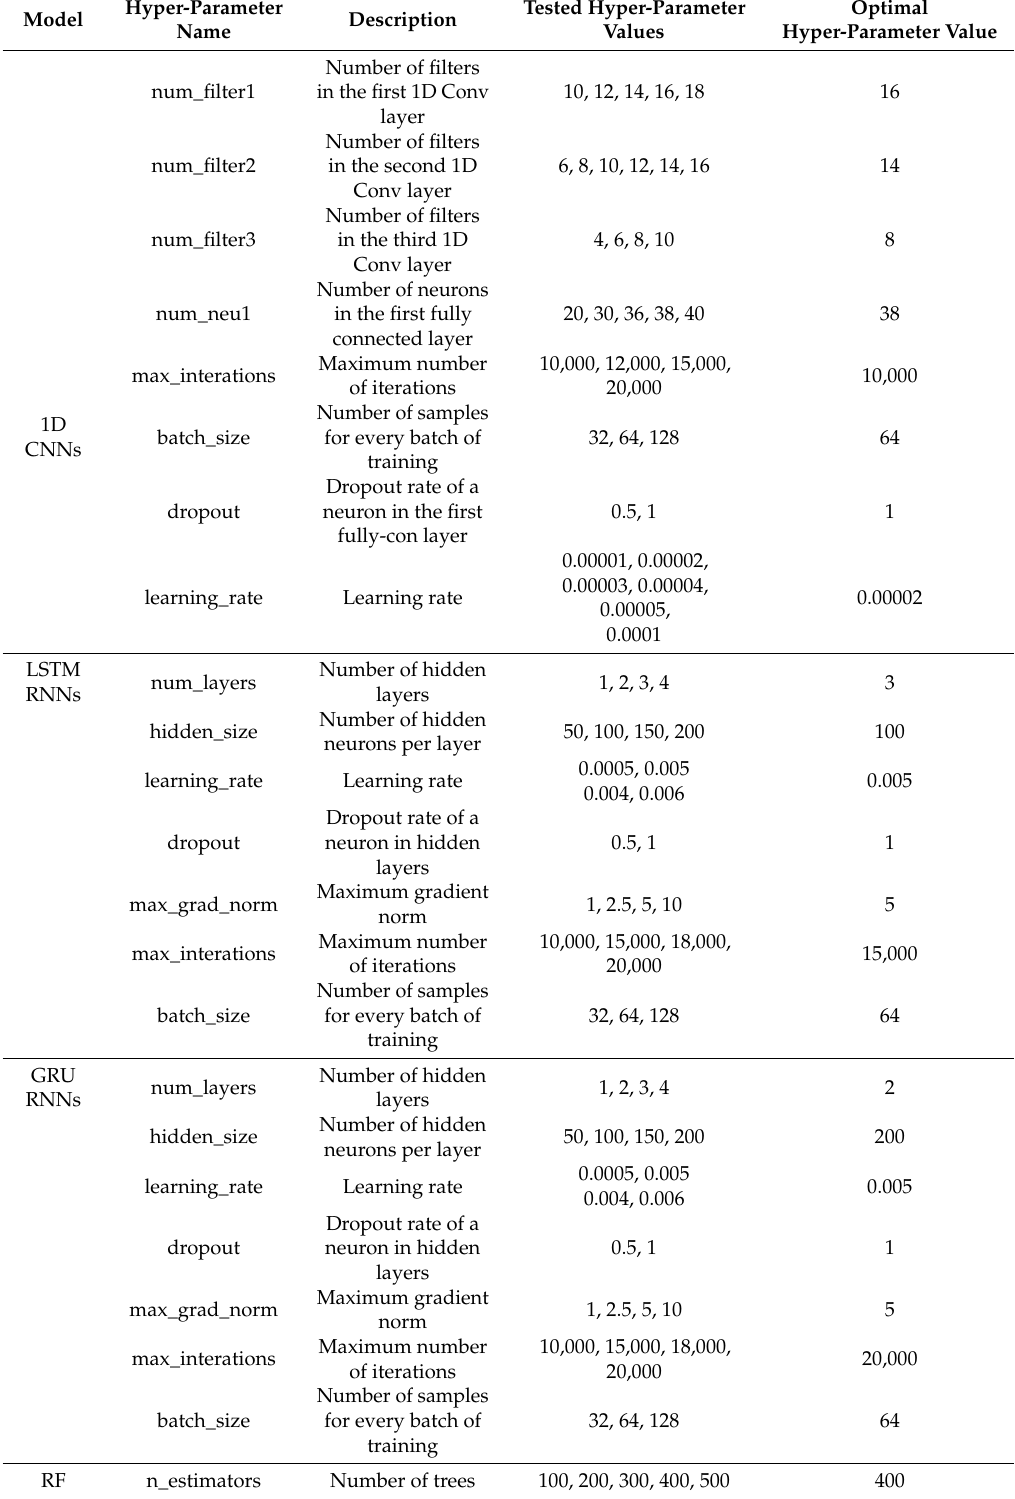
Table 2. Hyper-parameters. The test values of each hyper-parameter are sorted from small to large, rather than assembled into a training sequence. 1D CNNs, one-dimensional convolutional neural networks; LSTM RNNs, long short-term memory recurrent neural networks; GRU RNNs, gated recurrent unit RNNs; RF, random